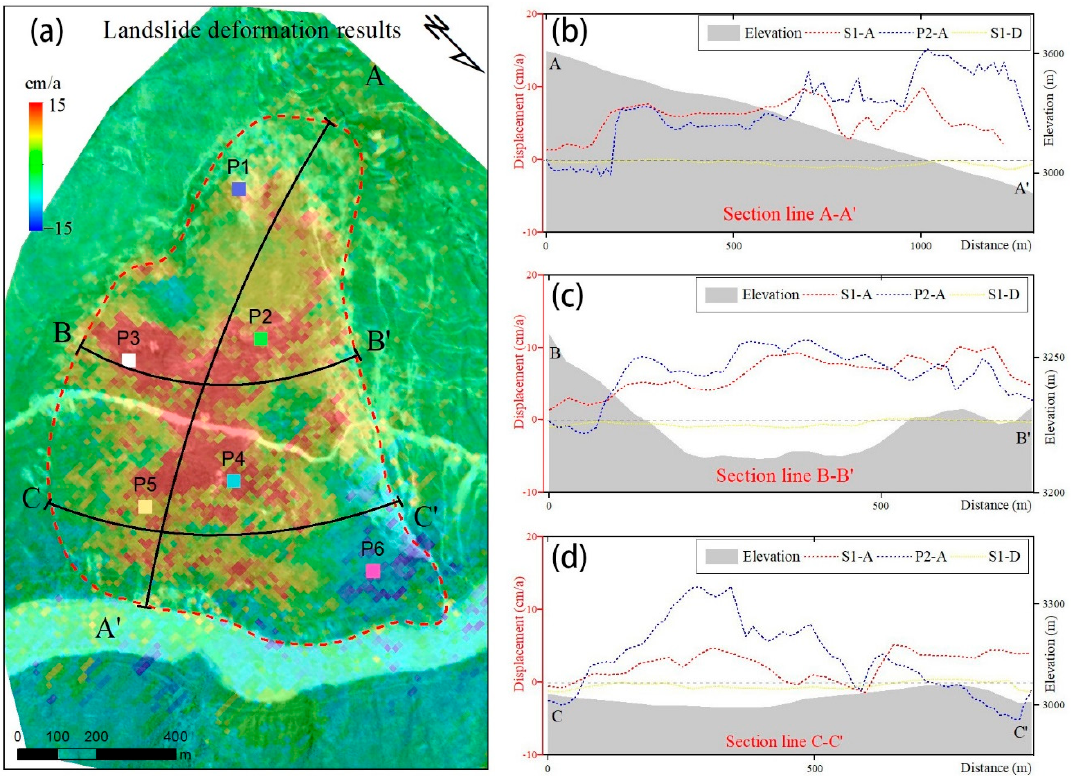
Figure 7. Displacement comparison of three profiles. The red, blue, and yellow dotted lines represent three direction measurement results. ( a ) Deformation results of the landslide; ( b – d ) Profiles A-A’ B-B’ and C-C’.